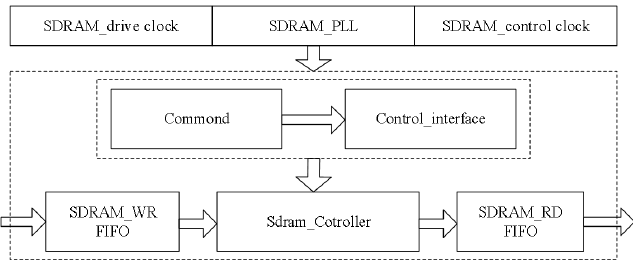
Figure 8. Structure of the SDRAM control unit.